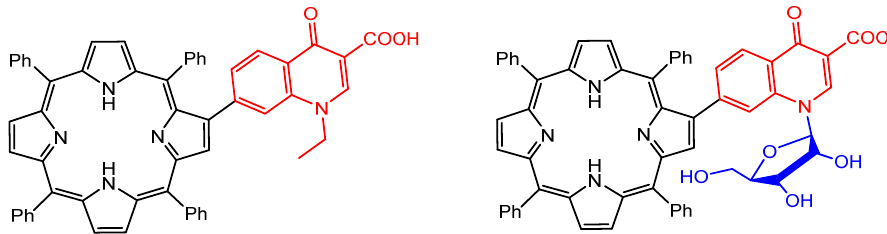
Figure 2. Free-base porphyrin/quinolone conjugates with high singlet oxygen production efficiency, produced by Gomes et al. [107].